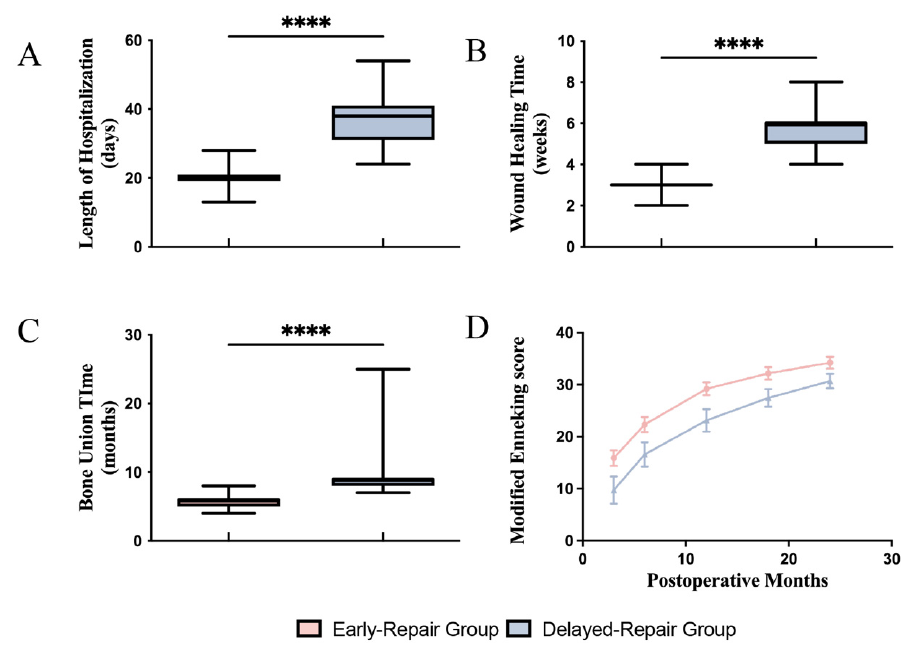
Figure 5. The short- and long-term follow-up of early- and delayed-repair group. ( A ) The LoS of delayed-repair group was 1.71 times longer than the early-repair group. ( B , C ) The wound healing time and bone re-union time were significantly longer in the delayed-repair group than the early- repair group. ( D ) All cases gained satisfying functional results by 24 months postoperative. However, the early-repair group gained better functional recovery throughout the follow-ups. LoS, length of hospitalization; **** p < 0.0001.